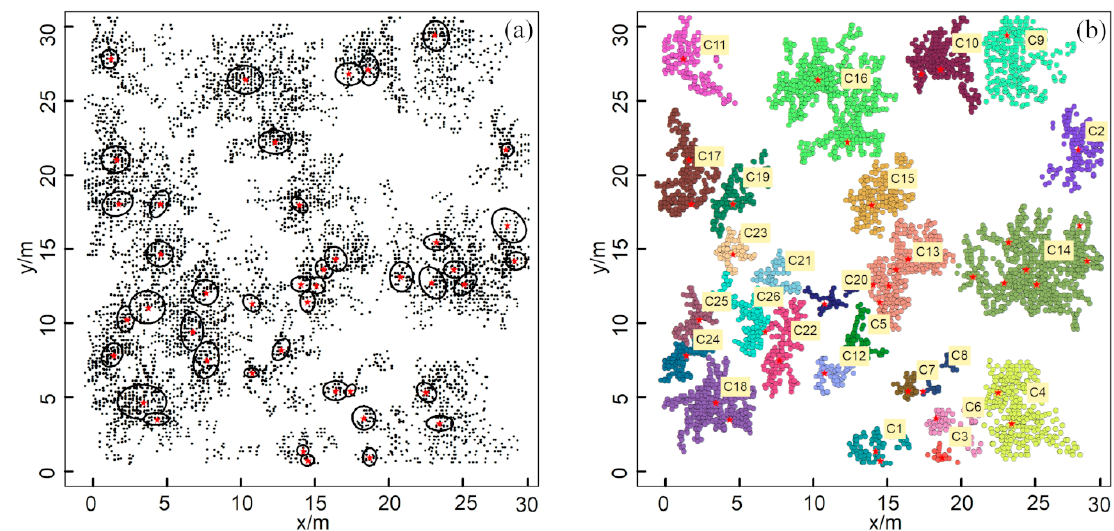
Figure 6. The field survey and clustering results from Site A: ( a ) 2-D top view of the root distribution generated by GPR; ( b ) clustering results produced by the HDBSCAN algorithm. Different colors represent the root points of different zones of influence (ZOIs).